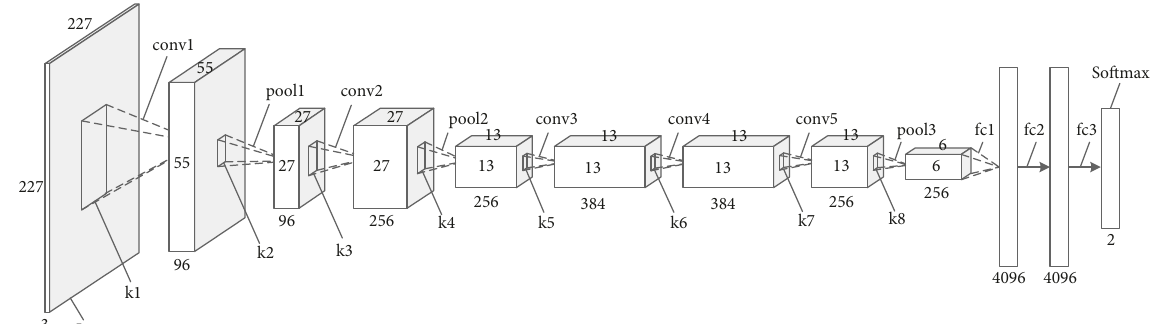
convolution; pool# (cid:31)